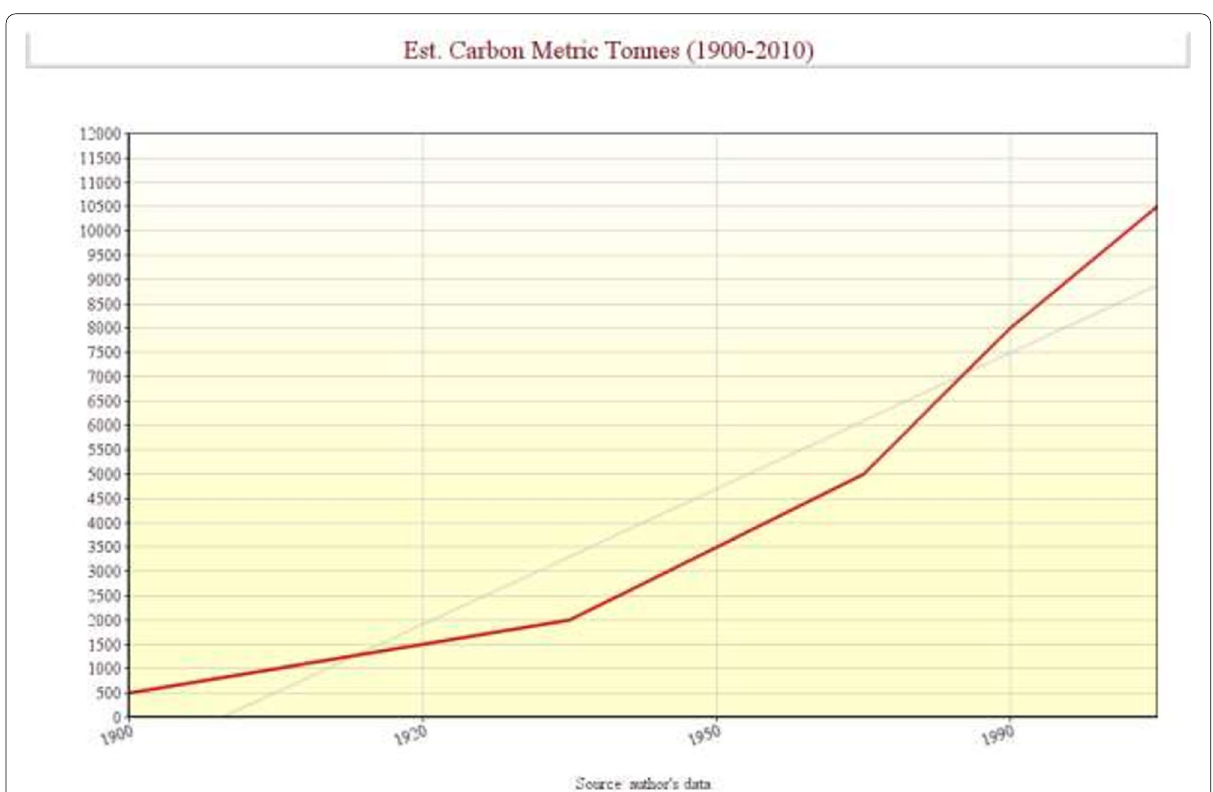
Fig. 2 Estimate from our Model starting 1900 beyond 2000: The figure shows an estimated increase and projected carbon discharges in Metric Tons over the period 1900–2010 from a previous study and estimated presented by the author Source: literature ; previous study, Adewole O.O et al.,